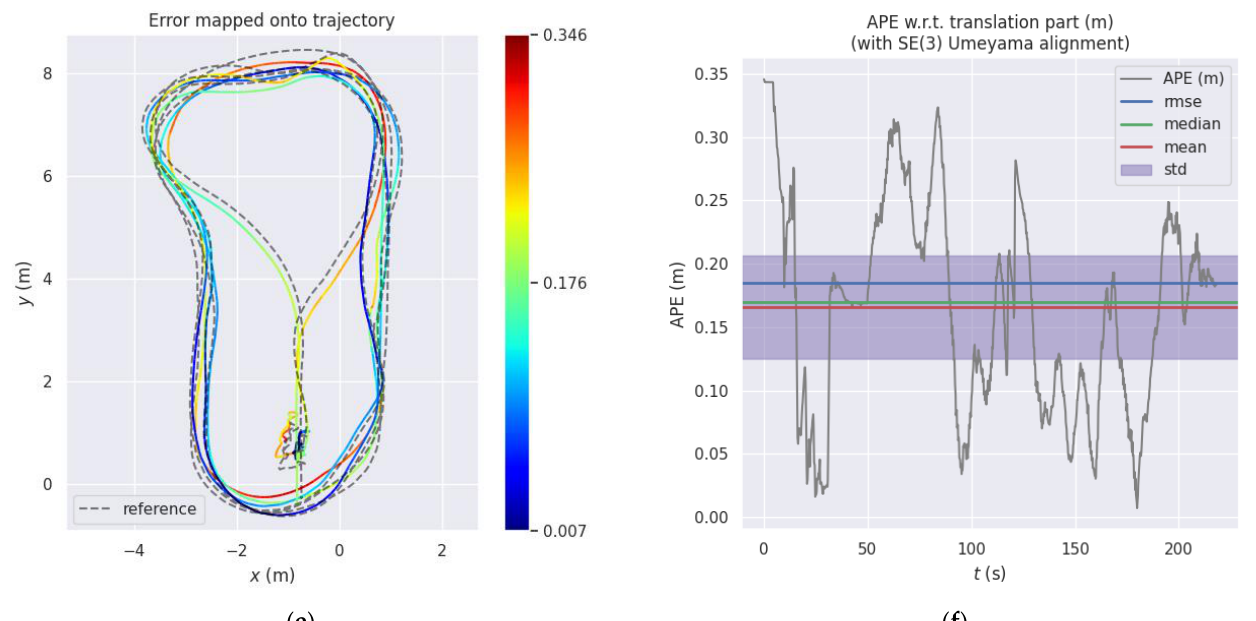
Figure 7. Comparison of the proposed method versus OpenVINS: ( a ) OpenVINS; ( c ) OpenVINS+IMU Pre-integration; ( e ) OpenVINS+IMU Pre-integration +Odom; ( b , d , f ) are the corresponding errors.